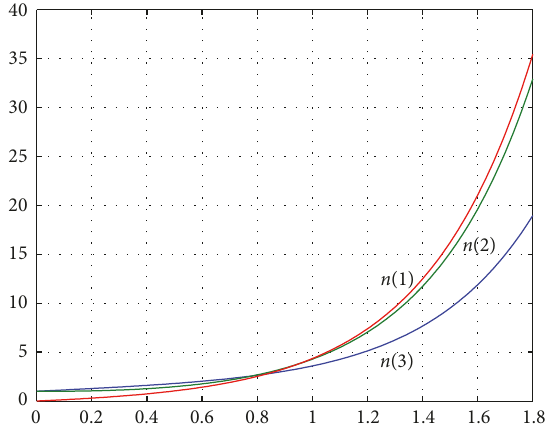
Figure 5: Evolution curve of variables when the initial state set as [0,1, 1] .